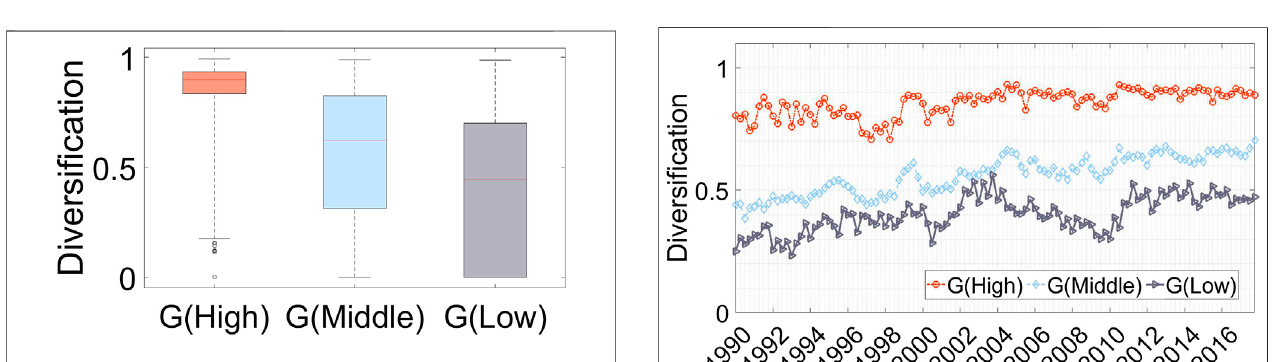
FIGURE 5 | We divide banks into three groups: high, middle, and low- centrality. The banks corresponding to the highest (lowest) 10% in terms of degreecentralityaredesignatedasthecore(peripheral)ofbanksinthispaper. The core banks have higher levels of diversi fi cation than middle and low- centrality groups.